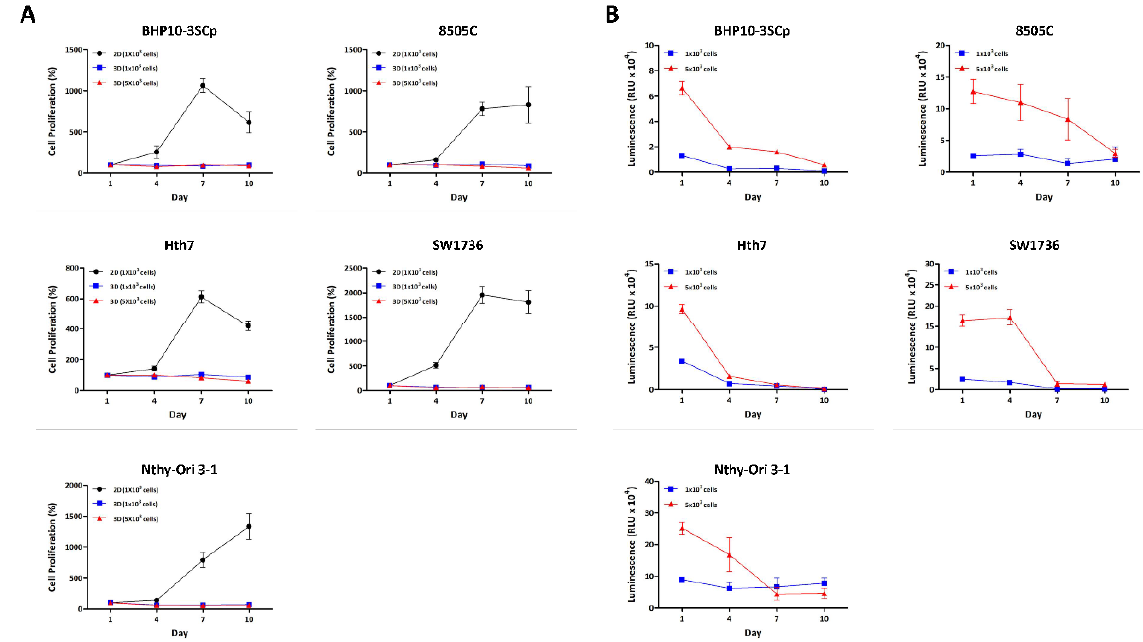
Figure 2. Cell proliferation between the 2D monolayer and 3D spheroid cultures. All cell lines were incubated in both 2D monolayer and 3D spheroid cultures until day 10. Cell proliferation was measured every 3 days using the CCK-8 reagent and CellTiter-Glo ® 3D Cell Viability Assay. ( A ) Cell proliferation between 2D monolayer culture and 3D spheroid culture with CCK-8 reagent. ( B ) Cell proliferation in 3D spheroid culture with CellTiter ‐ Glo ® 3D Cell Viability Assay.